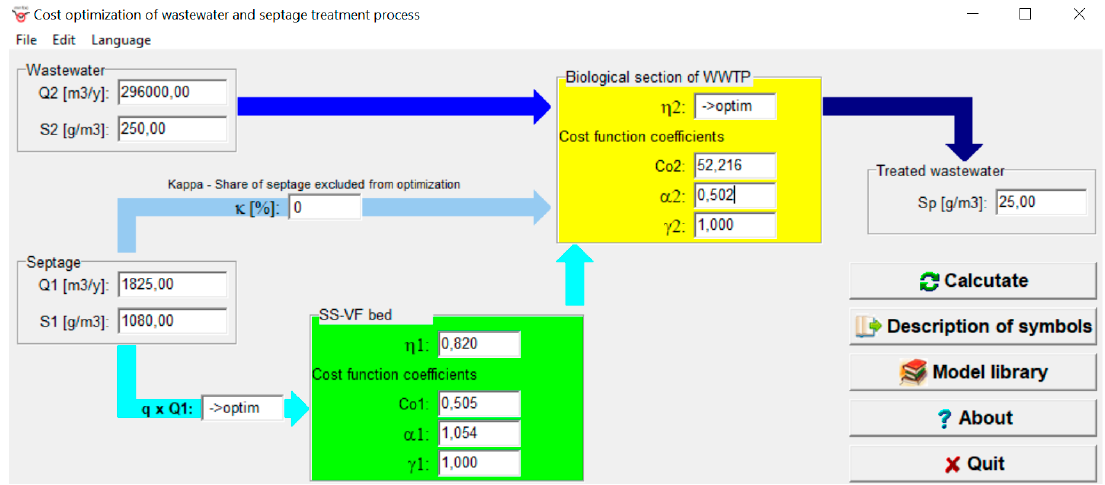
Figure 9. Computer program “Cost optimization of wastewater and septage treatment process”, example 3—summary of the input data.